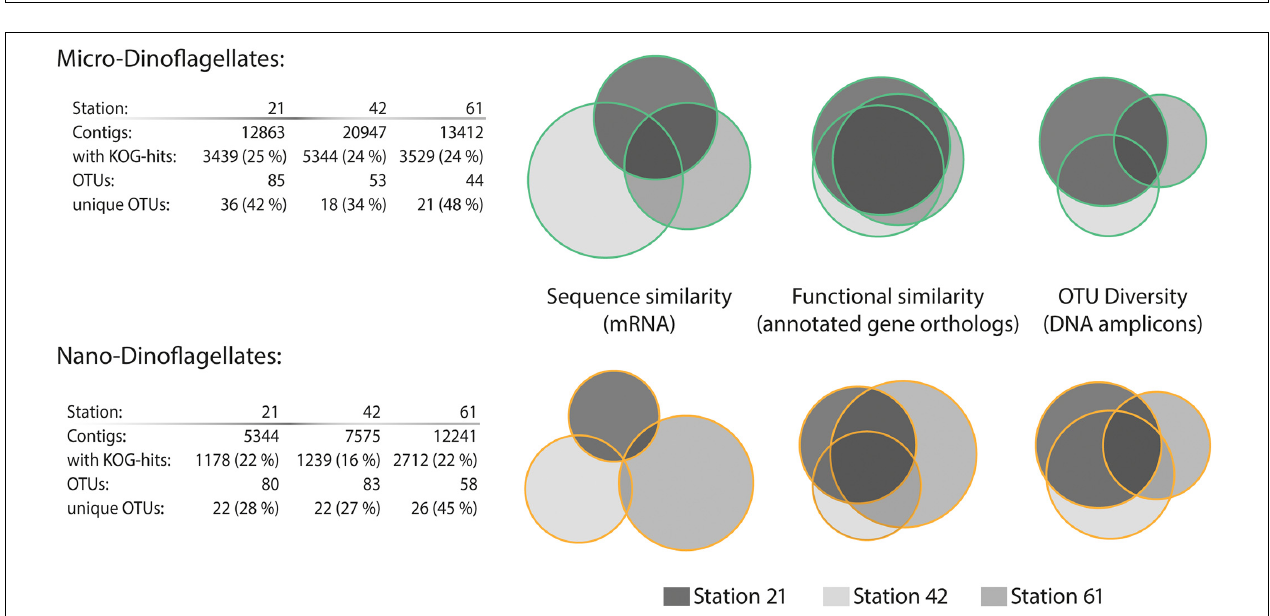
FIGURE 1 | Distribution of order- and genus metabarcodes (OTUs) assigned to dinoflagellates. (A) Dinoflagellate-OTUs obtained from the microplankton size fraction (20–50 µ m) and dinoflagellate-OTUs obtained from the nanoplankton size fraction (3–20 µ m). Gray bars on the left show OTU assignments to orders greater than 1% abundance (lower abundant orders in ‘Others’). Gray shaded bars show the subdivision into assigned genera with most abundant genera labeled if applicable. (B) Plot of the OTU distribution based on principal component analysis and similarity of OTU distribution as cluster dendrogram. Percentages of variance accounted for by each principal component are given in brackets.